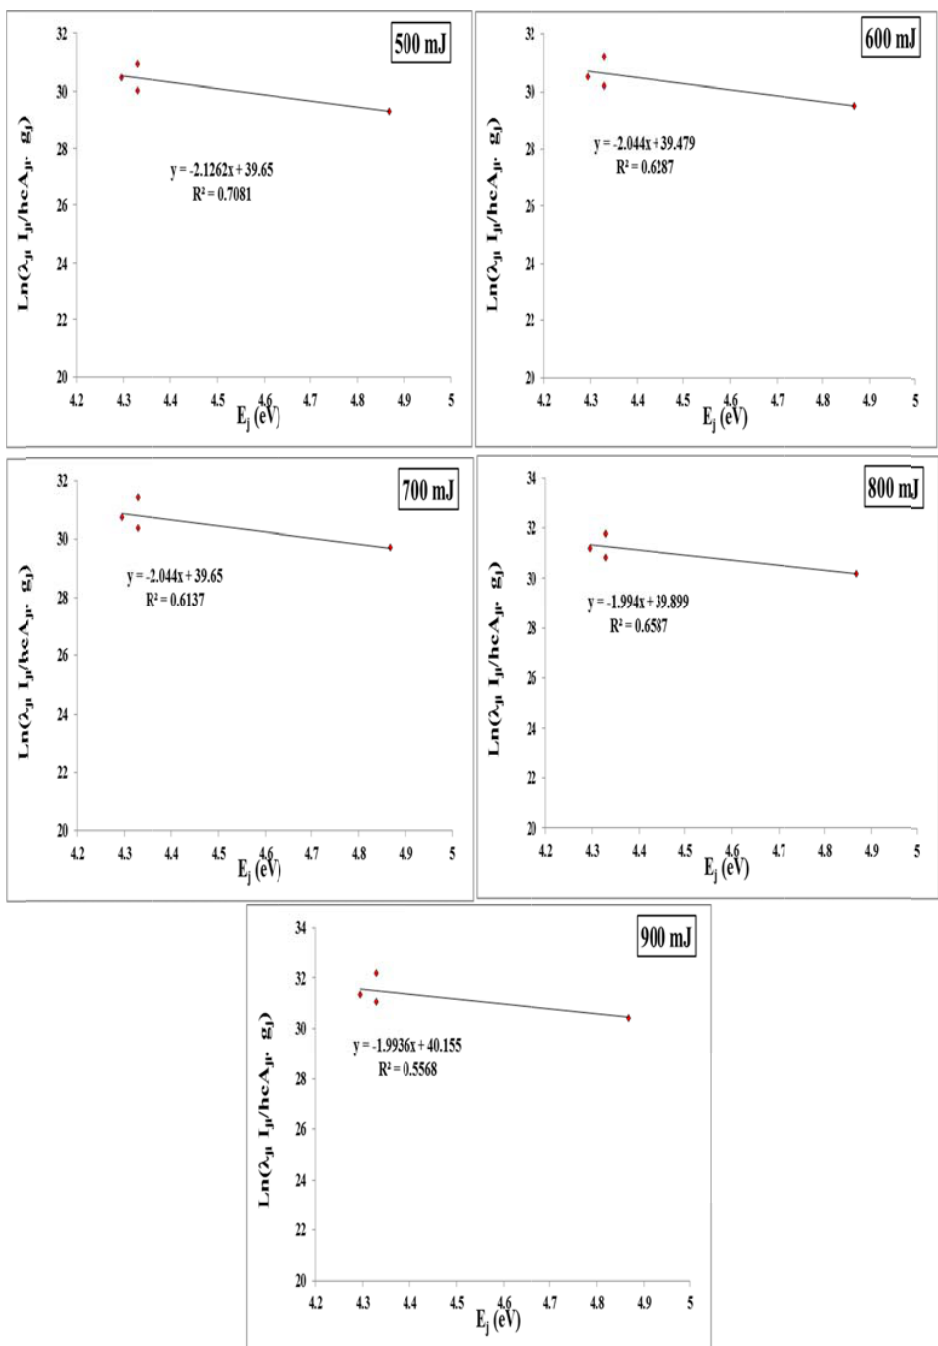
5: Boltzman ener T calc as s broa